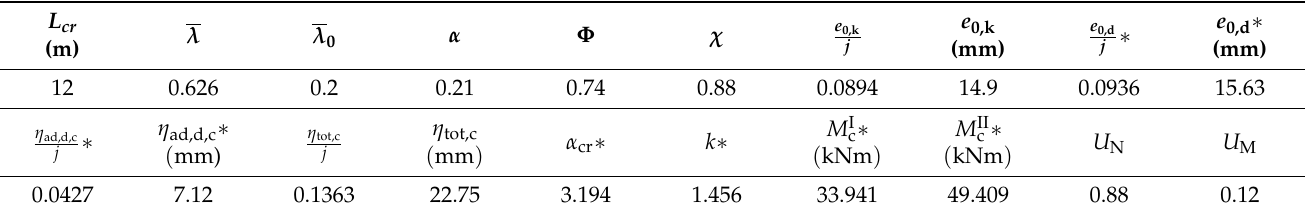
Table 3. Results of the second-order theory for flexural buckling perpendicular to strong axis